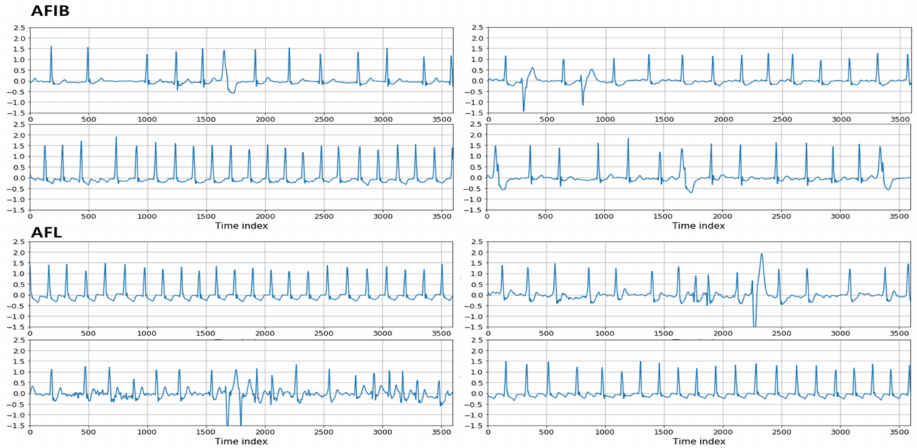
Figure 4. Examples of AFIB and AFL